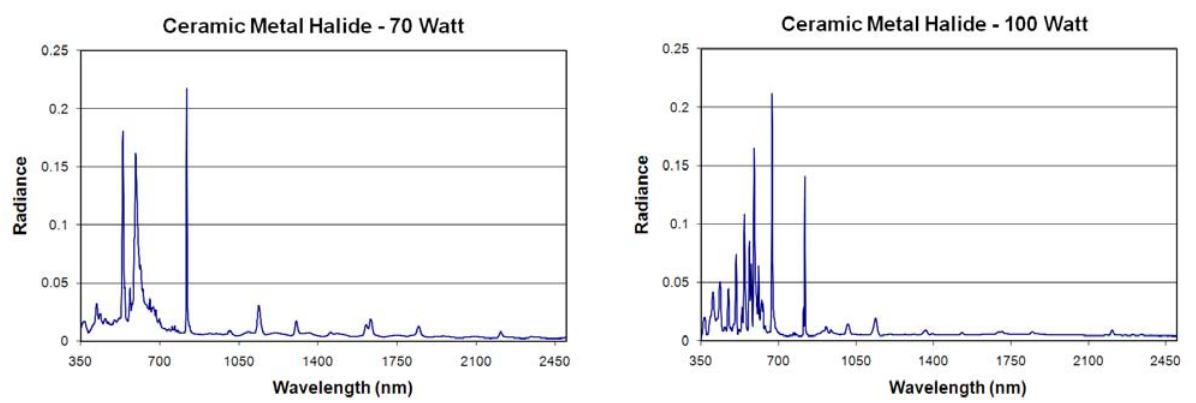
Figure 12. Emission spectra of four metal halide